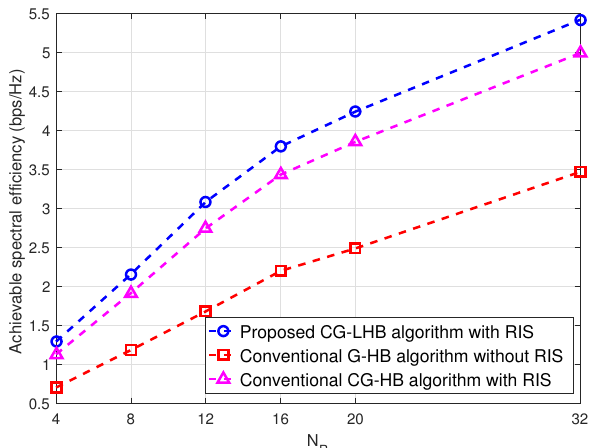
Figure 4. Spectral efficiency versus transmit power for the proposed RIS−assisted CG−LHB algorithm.